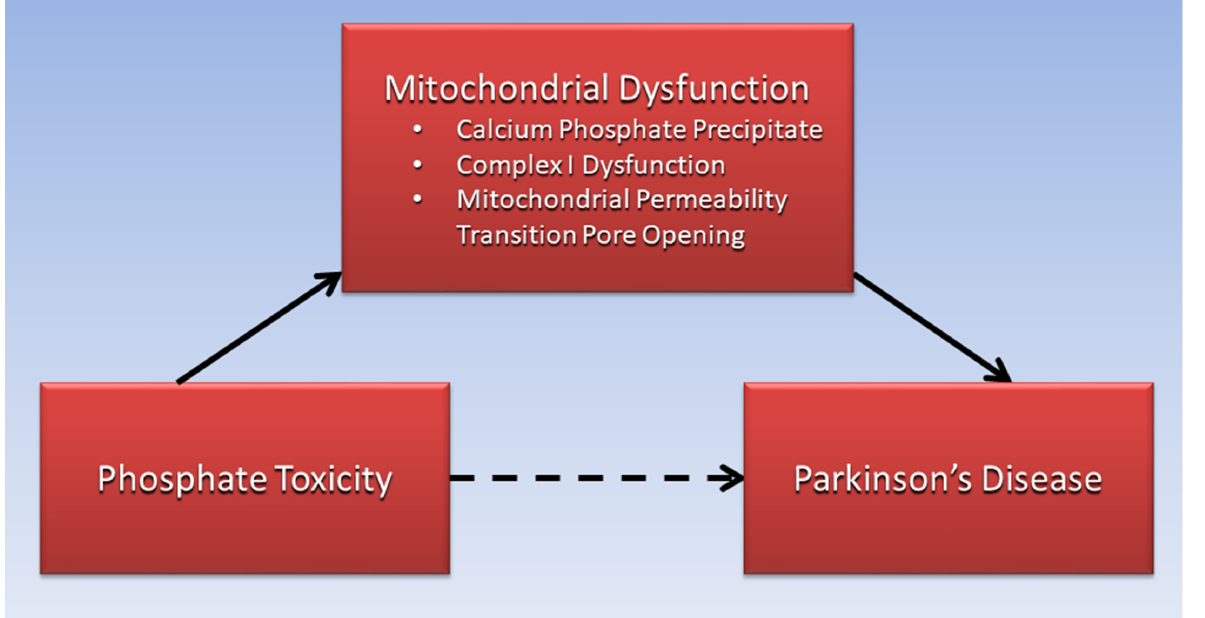
Figure 1. Mitochondrial dysfunction is proposed to mediate the association of phosphate toxicity with Parkinson’s disease.